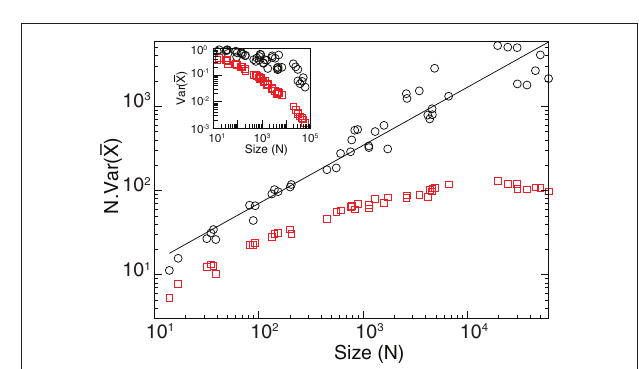
FIGURE A3 | Long-range correlations. Black circles correspond to brain data and red squares to the results from an exponential interaction model with the same geometry for each cluster. In the exponential case as N grows the average correlation converges, meanwhile for the brain data it continues growing demonstrating the presence of long-range correlations in the data. The black line corresponds to a power law fit y = kx − 0 . 7 . From Equation 21 we obtain an exponent α = 0 . 9. The inset corresponds to the variance of the mean activity as a function of N